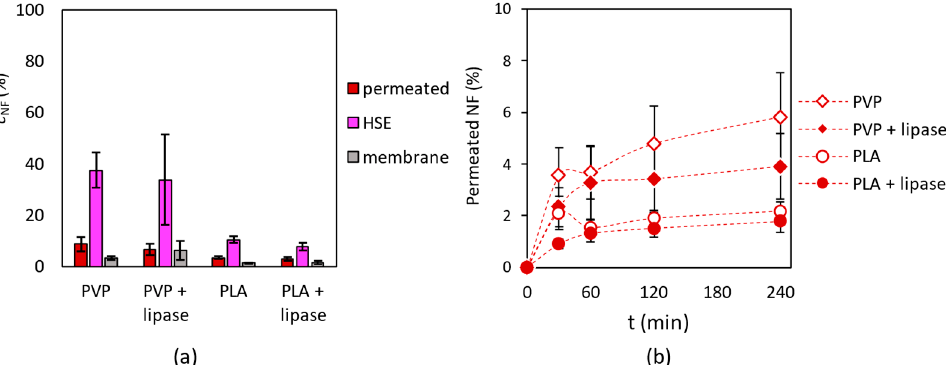
Figure 10. Investigation of nadifloxacin (NF) penetration into human heat-separated epidermis (HSE) applying a topical and transdermal diffusion cell system. ( a ) The concentration of NF in acceptor phase (permeated), in the HSE and in the membrane after 24 h incubation, and ( b ) the amount of permeated NF in a 4 h timeframe at 33 ◦